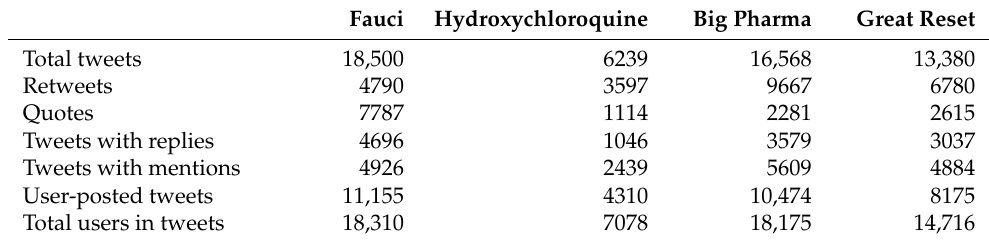
Table 5. Statistics for the collected COVID-19-related Twitter disinformation datasets.